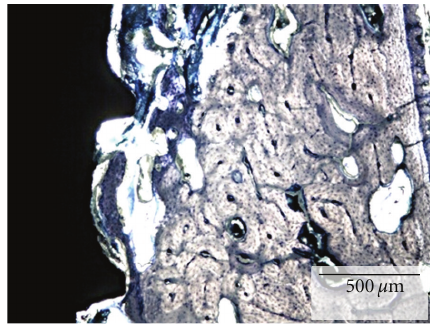
Figure 2: Optical micrograph depicting the new bone filling the gap between the extraction socket wall and implant surface, a common finding for both experimental and control groups.